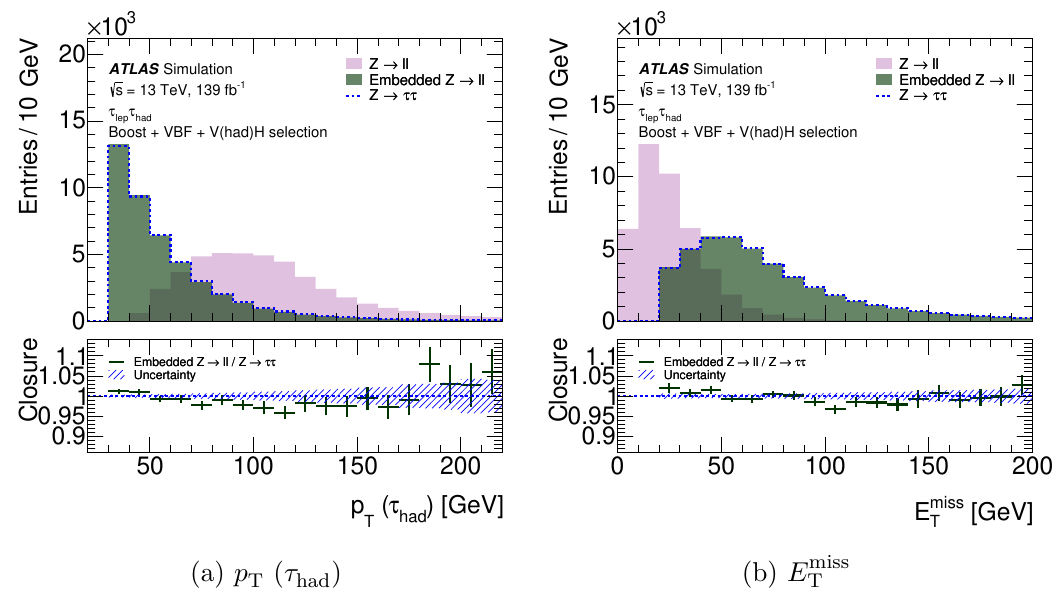
Figure 4. Comparison of kinematic quantities for Z → ‘‘ simulated events in the τ τ channel lep had before (light purple histogram) and after (dark green histogram) the embedding procedure, in the boost, VBF and V(had)H phase spaces combined. The distribution for Z → ττ simulated events (dashed blue line) is also shown. (a) p distribution of the simulated τ in the event. For the T had Z → ‘‘ events, the reconstructed lepton with the highest p in the event is shown. For the Z → ‘‘ T events after the embedding procedure, a scaling term is applied to the p of the lepton chosen to T mimic the τ as described in the text. (b) E miss distribution. The bottom panels display the ratio had T of embedded Z → ‘‘ events to Z → ττ events. The error bars display the statistical uncertainties in the ratio and the dashed blue band illustrates the statistical uncertainty in the Z → ττ